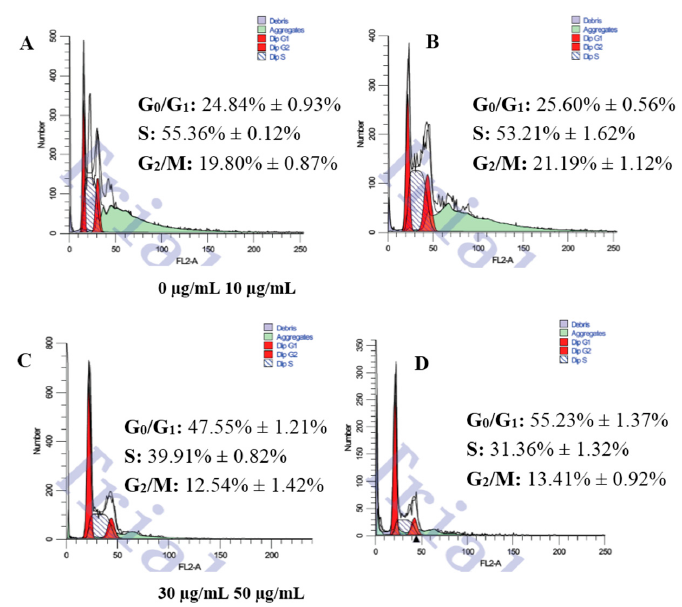
Figure 4. The effects of SBM on the cell cycle and the apoptosis rate of HepG2 cells. The cells (1 × 10 6 cells/mL) were treated with 0 μ g/mL ( A ), 10 μ g/mL ( B ), 30 μ g/mL ( C ) and 50 μ g/mL ( D ) of CGC for 48 h, respectively. Cell cycle distribution and apoptosis were analyzed by flow cytometry. All data were expressed as the mean ± SD ( n = 3).